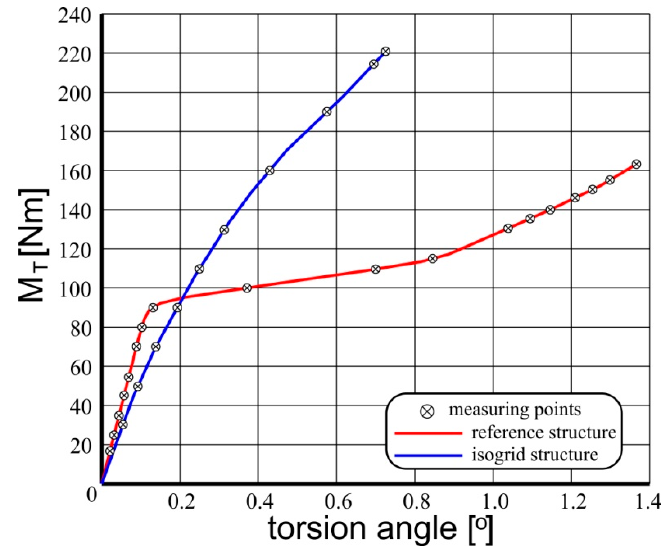
Figure 5. Representative equilibrium paths of the examined structures.